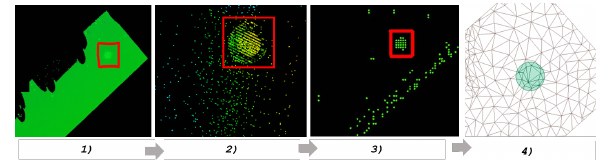
red rectangles encompassing the approximate location. Step